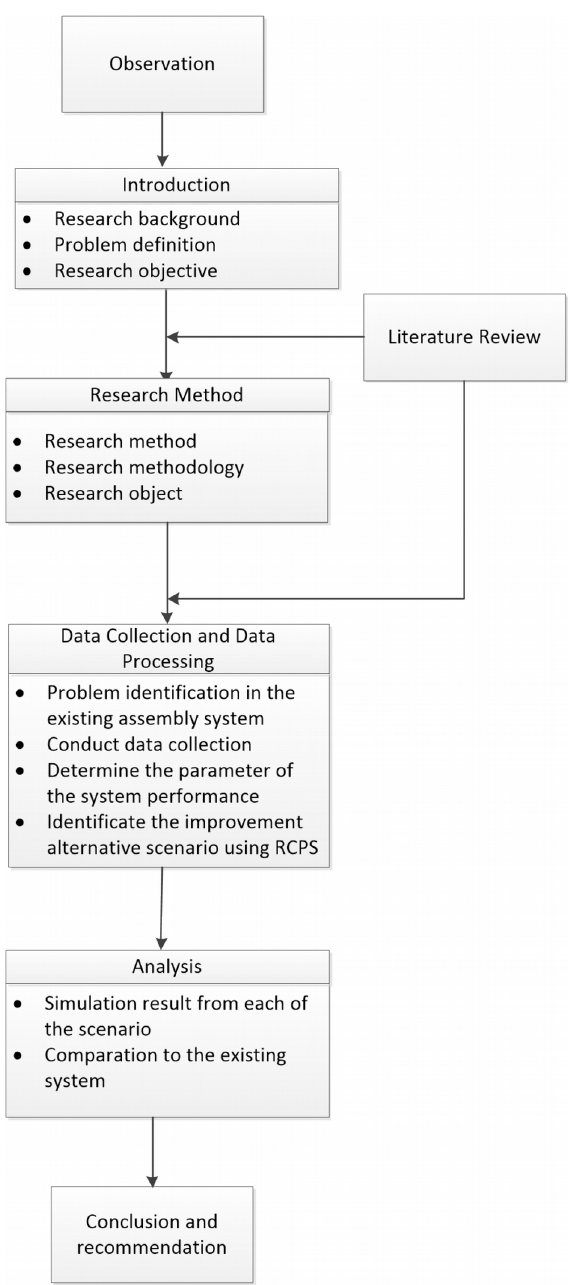
Figure 3. Research Methodology